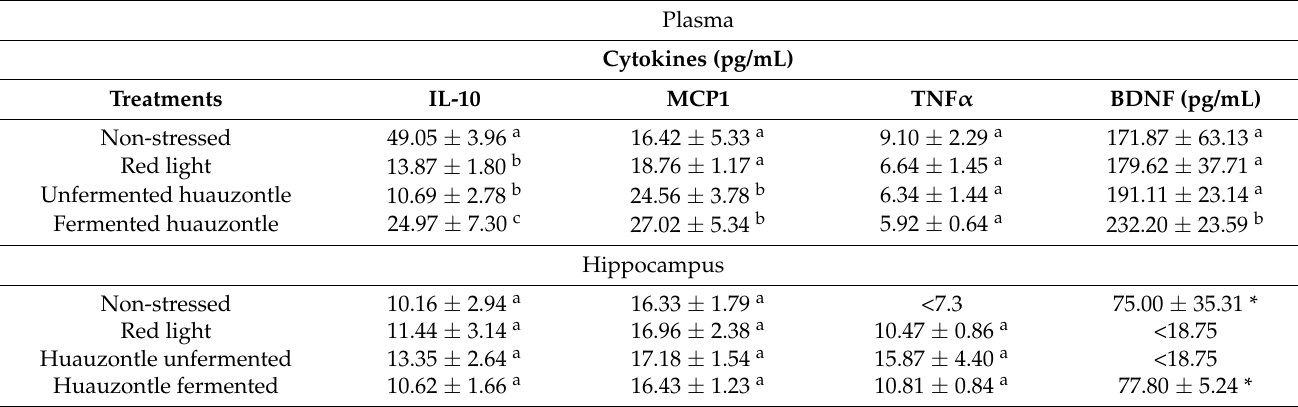
Table 2. Cytokines concentration, BDNF production in hippocampus and